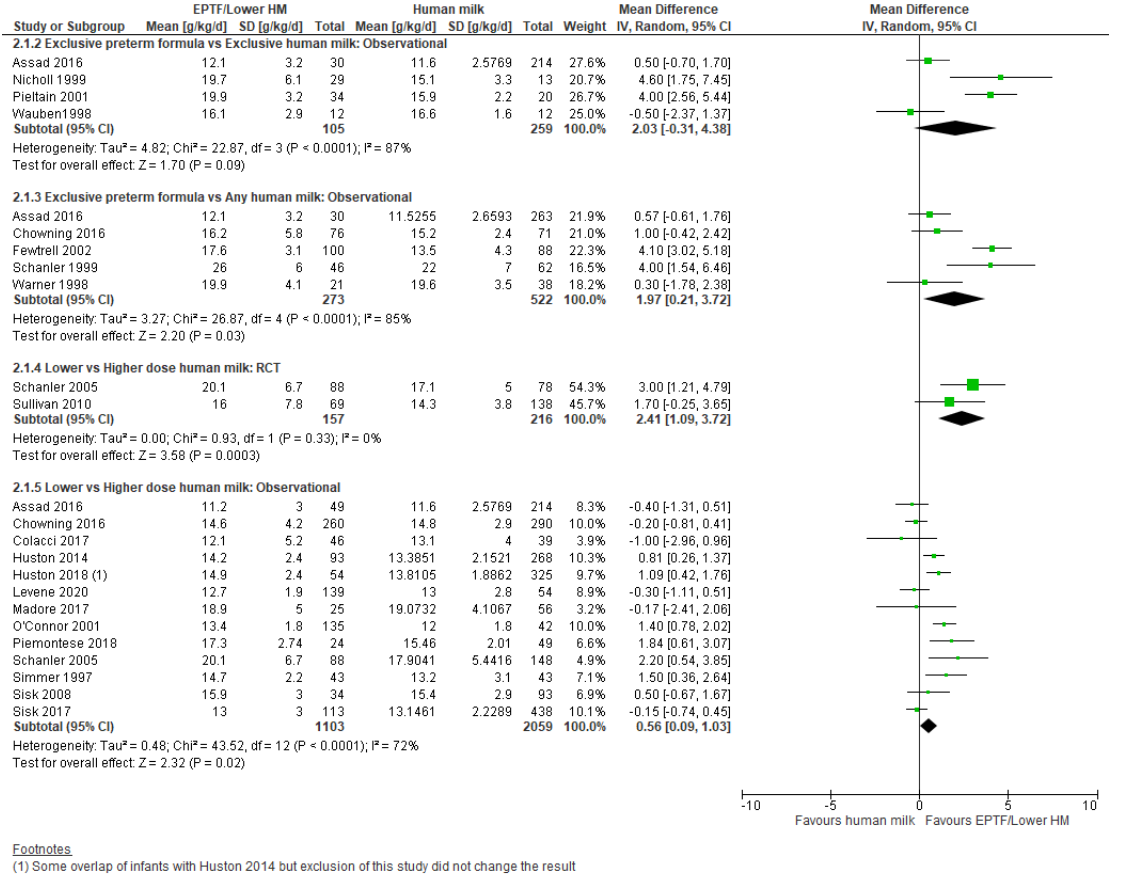
Figure 2. Forest plot of mean difference in weight gain (g/kg/day) and human milk intake.